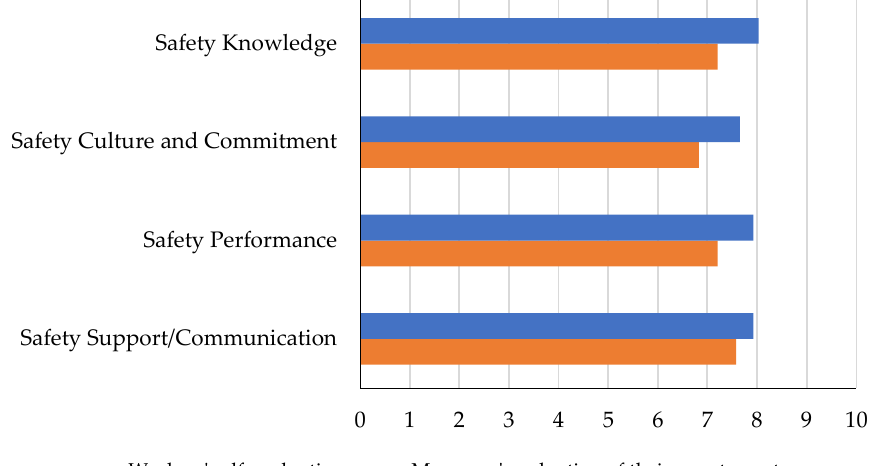
Figure 7. Workers’ safety evaluation.